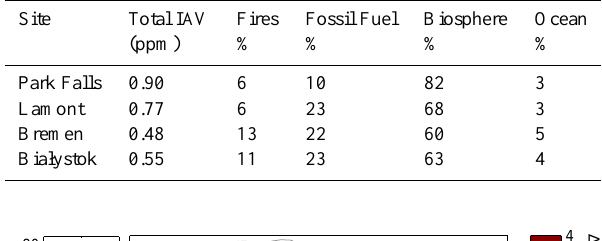
Table 5. The contribution of the four modules (fire, fossil fuel, ter- restrial biosphere, and ocean) to the total interannual variability (IAV) in CT2011. The total IAV is the standard deviation of the drawdown period CTX CO (in ppm), broken down into the fraction 2 of that variability caused by the four modules (in percent).